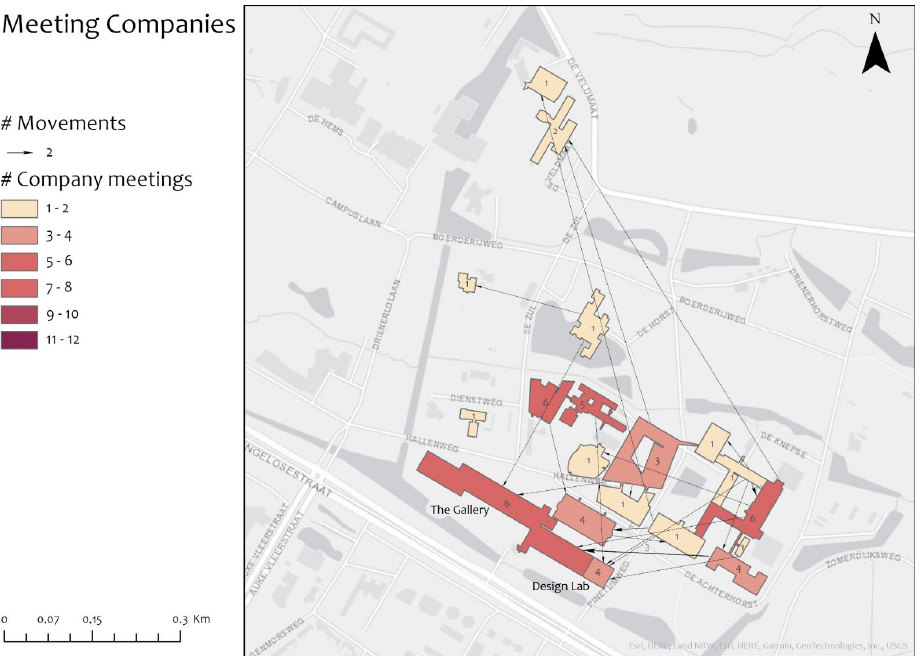
Figure A5. UT campus—meetings with companies and movement across campus. # = ‘Number of’.